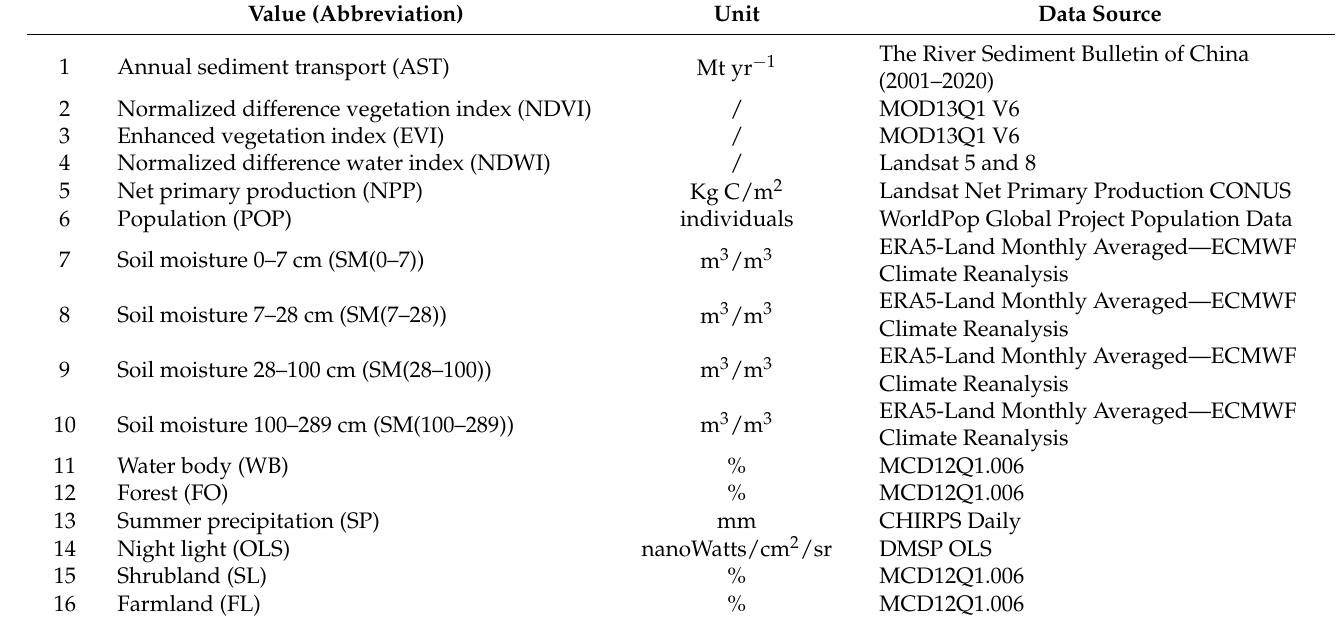
Table 1. Driving factors and data